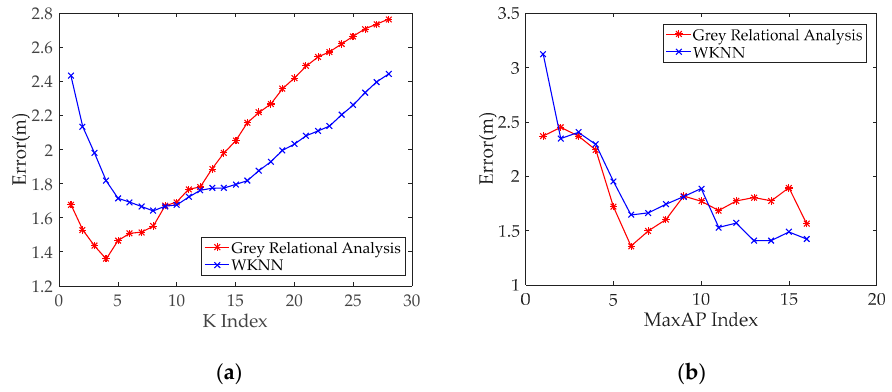
Figure 7. Positioning performance of the conventional fingerprint method and proposed method with the parameter changing: ( a ) parameter K and ( b ) the number of selected Max access points (APs).